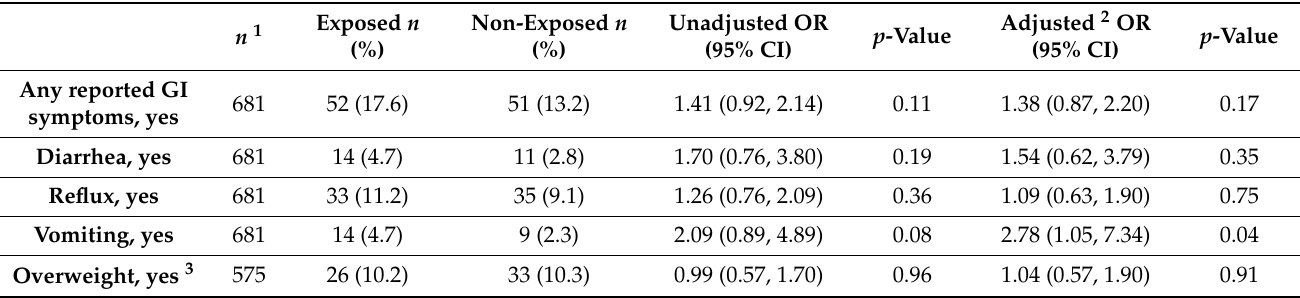
Table 3. The association between infants’ low-calorie sweetener exposure via maternal postnatal diet beverage intake and risk of any reported gastrointestinal (GI) symptoms and overweight at 3 months of